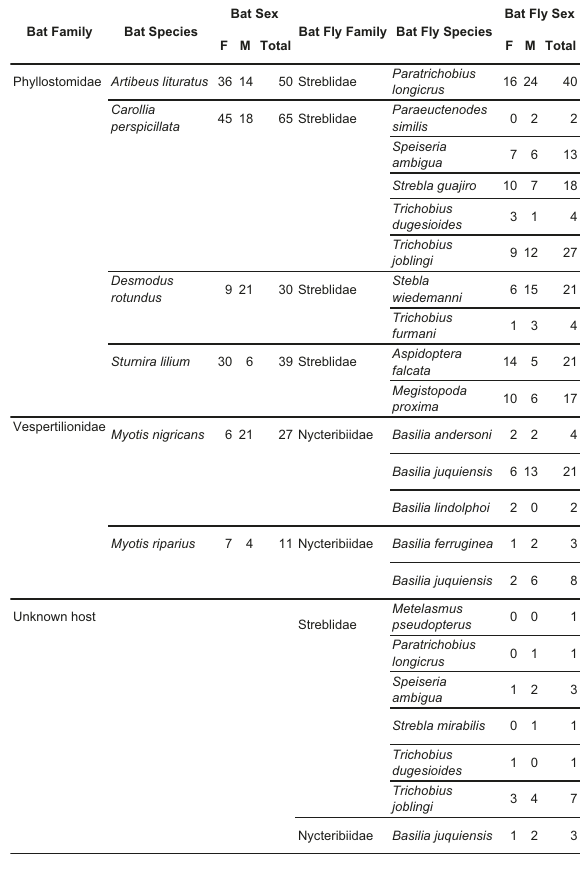
Table 1. Sampling of bats and their corresponding fl ies used for